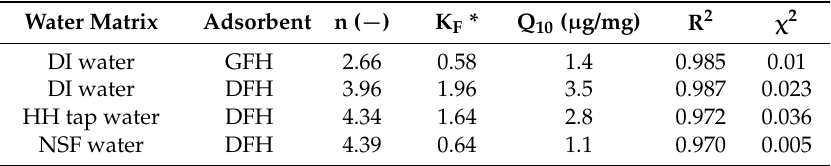
Table 4. Parameters of the Freundlich isotherm in the case of As(III), along with the correlation coefficients and the chi-squared values. Water Matrix Adsorbent n ( −